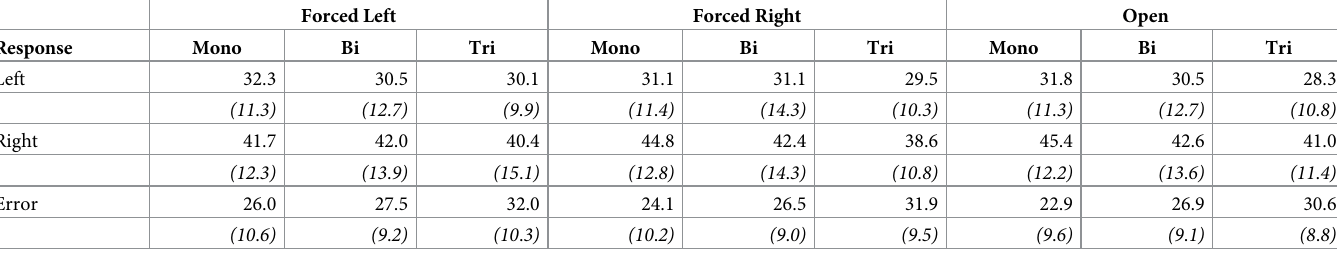
Table 1. Percent plosives selected for each ear as a function of condition and type of oral contraceptive. Forced